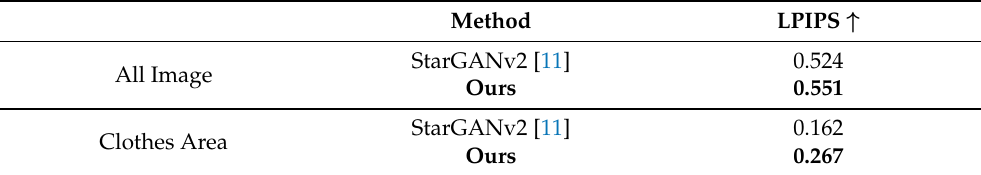
Table 2. Quantitive comparison between StarGANv2 and our method. Results with and without background are reported separately. (Bold represent the best